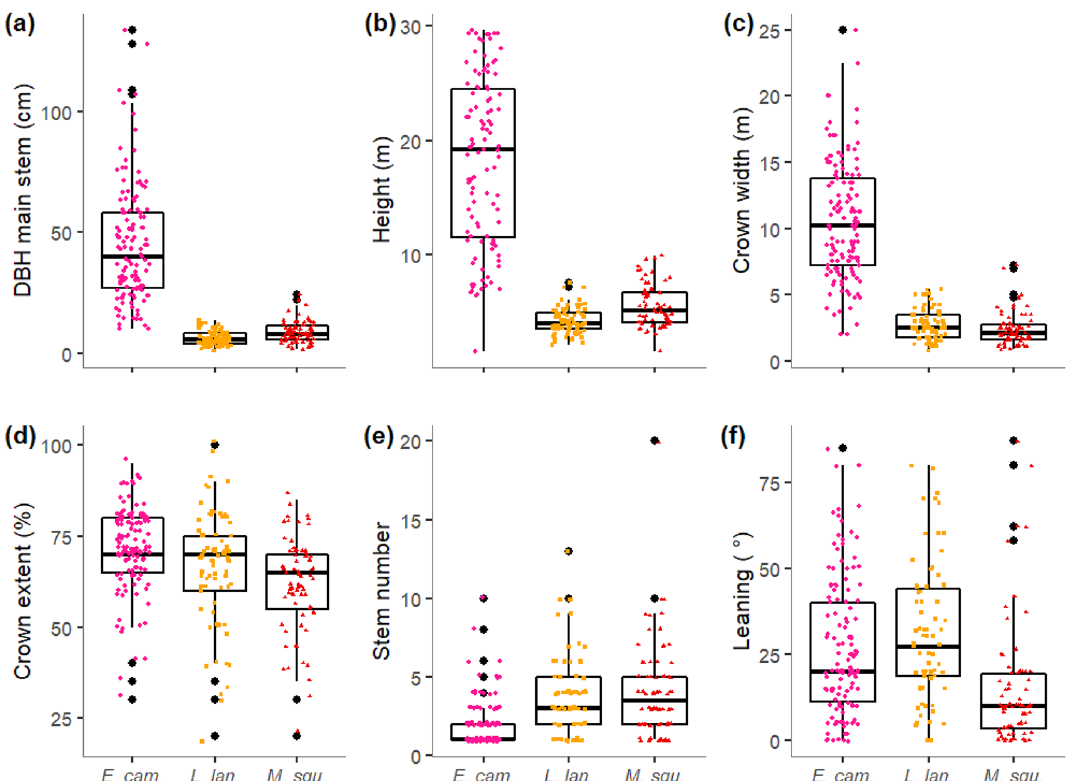
Figure 3. Boxplots of main stem DBH ( a ), plant height ( b ), crown width ( c ), crown extent ( d ), stem number ( e ) and stem leaning ( f ) for surveyed plants of the three studied species. Coloured points indicate raw data (n = 129 for E. camphora , n = 75 for L. lanigerum , n = 74 for M. squarrosa for all variables except for plant height for which n = 108 for E. camphora and n = 74 for L. lanigerum ). DBH diameter at breast height, E. cam = E. camphora , L. lan = L. lanigerum , M. squ = M. squarosa . The figure was generated in R version 3.5.0 (https:// www.r- proje ct.